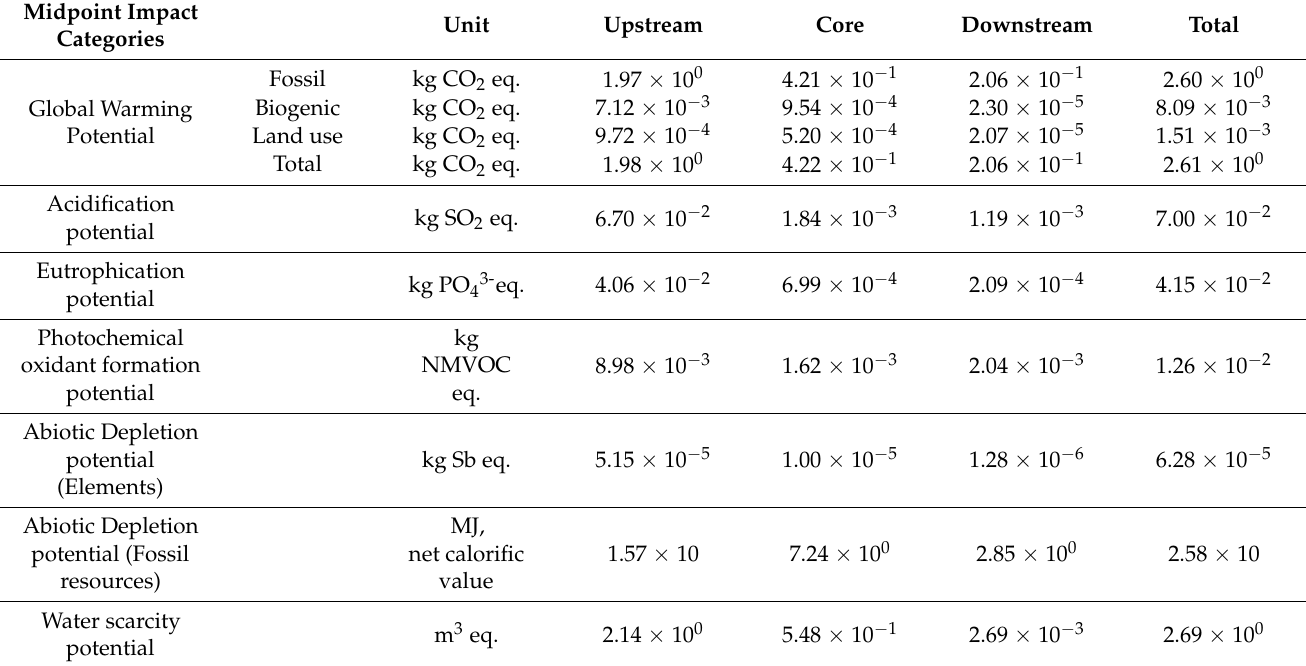
Table 9. Midpoint LCA indicators of one bottle of organic olive oil (0.5 L). Source of the data: